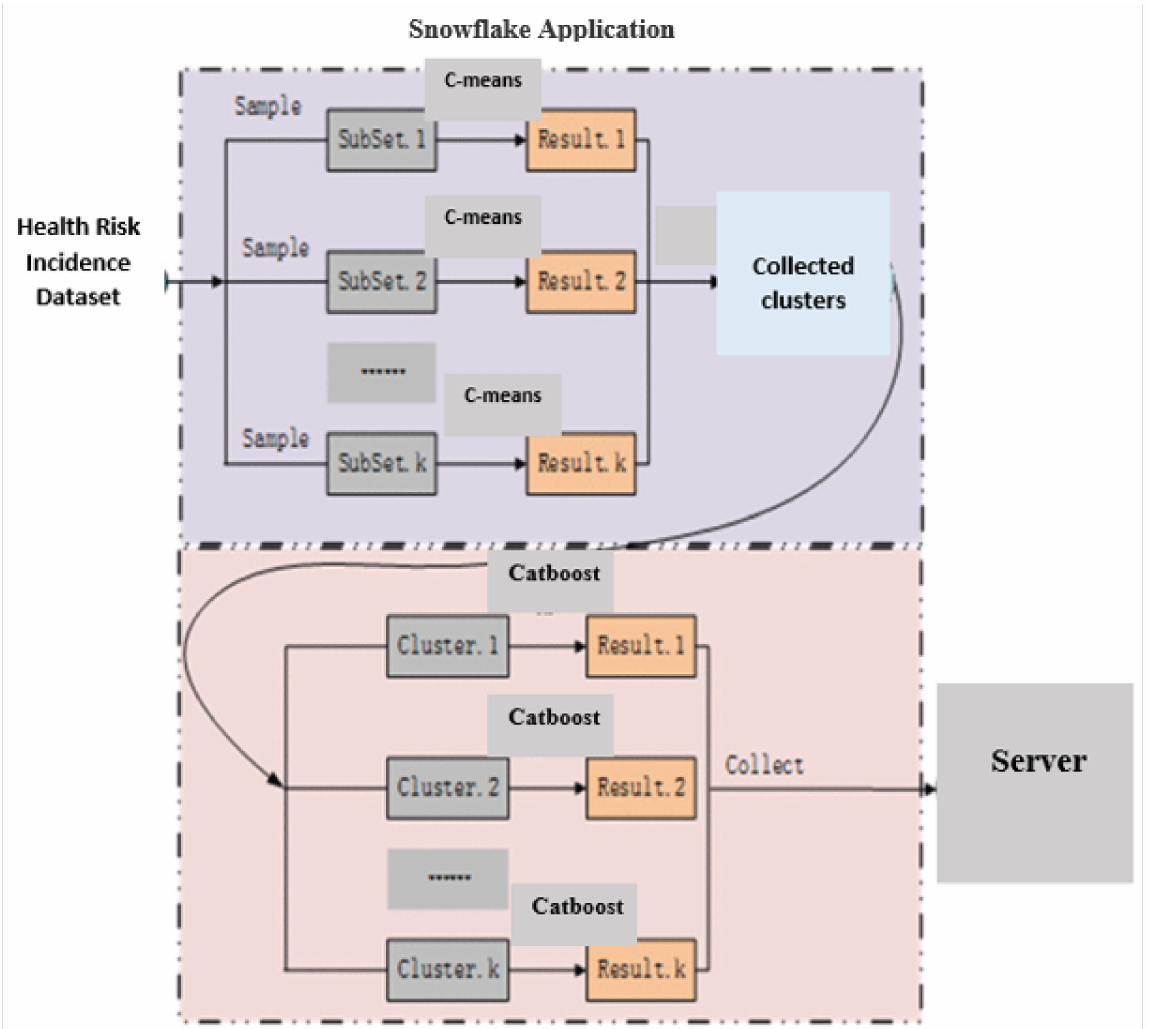
Figure 5. The distributed binary monitoring prediction system. Health risk incidences are inputted to the distributed training system and the results are computed and gathered in the first phase. The gathered clusters are fed to the Catboost classifiers in the second phase and collected and sent to the